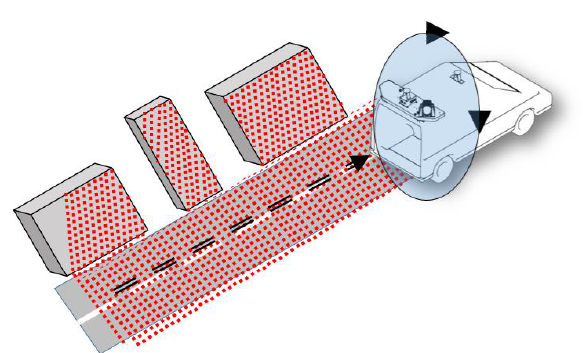
Figure 1. Principal movement components of Mobile LiDAR